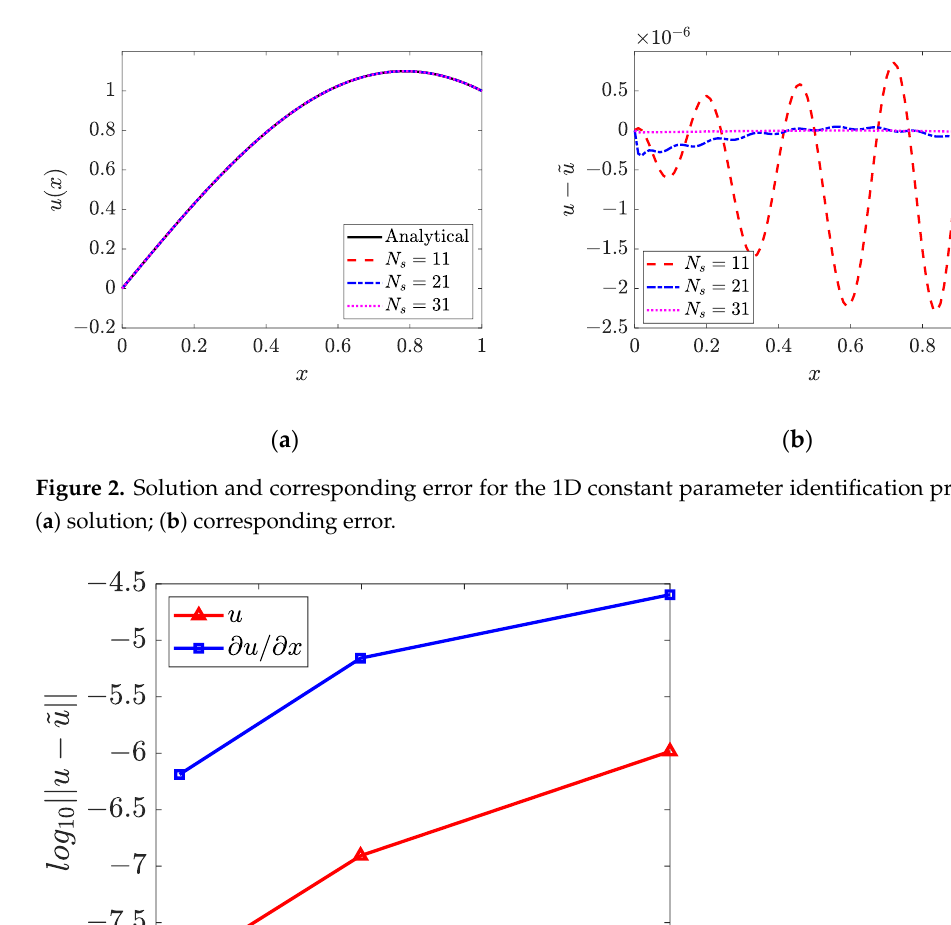
Figure 3. Convergence of the solutions for the 1D constant parameter identification problem.